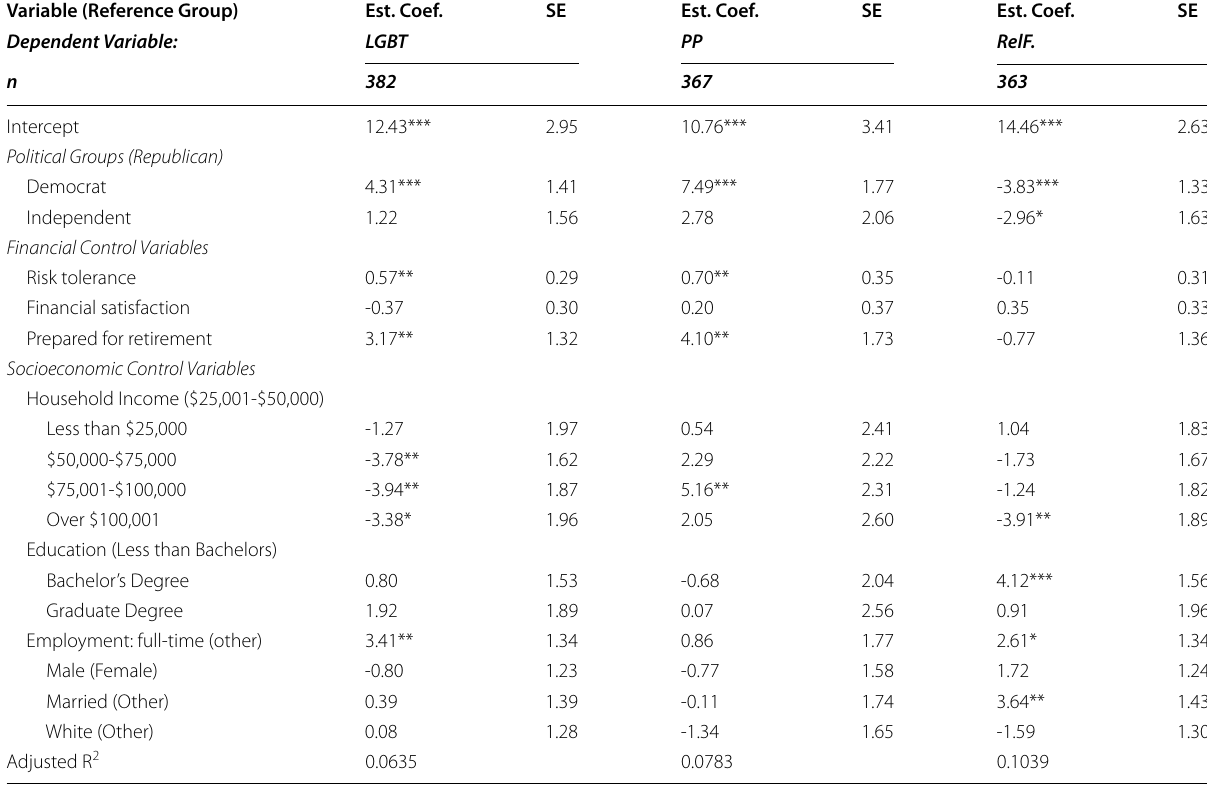
Table 3 OLS regression results